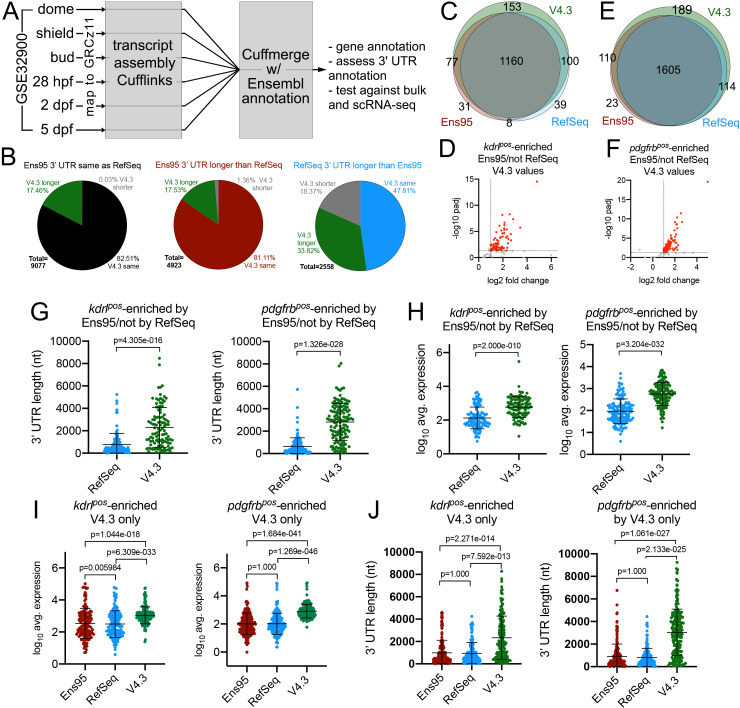
The V4.2 annotation improves detection of cell-type-specific genes from bulk RNA-seq data.(A) Schematic outline for generating a new zebrafish transcriptome annotation. See Results and Materials and methods sections for details. (B) Pie charts showing the proportion of reference genes with same, longer or shorter 3' UTR in the V4.3 annotation compared to relative 3' UTR length between Ens95 and RefSeq. (C, E) Venn diagrams showing intersection of reference genes with commonly annotated NCBI ID that are significantly enriched in (C) kdrlpos- or (E) pdgfrbpos-cells in each indicated annotation. (D, F) Volcano plots of reference genes with common NCBI ID identified as (D) kdrlpos- or (F) pdgfrbpos-enriched only by Ens95 in comparison to RefSeq. Indicated values are from the same genes quantified using V4.3. Red dots indicate log2 fold change >1 and adjp <0.05. (G) 3' UTR lengths and (H) log10 average expression (n = 3) using RefSeq and V4.3 for reference genes in the indicated dataset. (G, H) Data are not normally distributed, Wilcoxon matched-pairs signed-rank test, p values are indicated. Error bars denote mean and standard deviation. (I) Log10 average expression (n = 3) and (J) 3' UTR lengths across all annotations for reference genes uniquely identified as enriched in indicated transgene-positive cell type using V4.3 (log2 fold change >1, padj <0.05). Data are not normally distributed. Friedman test to assess variance (p<0.0001 in all cases). Dunn's multiple comparison test was used for pairwise comparisons, p values are indicated. Error bars denote mean and standard deviation.Figure 3—source data 1.List of SRA accession numbers, stages, and read numbers from GSE32900 for associated RNA-seq datasets used in this study.Figure 3—source data 2.List of manually-identified discrepancies in Ensembl gene annotation due to spurious fusionor overlapping transcripts.Table includes Ens95 gene symbol, gene ID, and spurious transcript ID. Persistence of observed discrepancy in Ens99 is indicated, as is previous status of curation in ZFIN. All of these have been reported to ZFIN.Figure 3—source data 3.RefSeq (worksheet 1) and Ens99 (worksheet 2) genes missing from the V4.2 annotation.Figure 3—source data 4.Novel genes from V4.2 genome annotation.This table includes information regarding blastx hits against zebrafish and human proteins, matches with lincRNAs, number of exons per gene, and whether the novel locus was included in the V4.3 annotation.Figure 3—source data 5.V4.3 gene information table, including unique LL ID numbers, associated Ens99 gene ID, NCBI ID, and ZFIN gene ID numbers, gene symbols, and gene names.Annotation notes are also included regarding the relative strength of coordinate-based incorporation of NCBI (Entrez) and Ens99 gene identifiers.Figure 3—source data 6.Output from DESeq2 analysis comparing kdrlpos and kdrlneg RNA-seq.Gene expression levels were quantified using RSEM with the V4.3 annotation. Median ratio normalized expression values are shown for each sample, along with adjusted p-value and log2 fold change. Matching Ensembl and NCBI gene IDs are included.Figure 3—source data 7.Output from DESeq2 analysis comparing pdgfrbpos and pdgfrbneg RNA-seq.Gene expression levels were quantified using RSEM with the V4.3 annotation. Median ratio normalized expression values are shown for each replicate, along with adjusted p-value and log2 fold change. Matching Ensembl and NCBI gene IDs are included.Figure 3—source data 8.Worksheet 1 - Output from DESeq2 analysis comparing Nr2f2pos and Nr2f2neg RNA-seq.Gene expression levels were quantified using RSEM with the V4.3 annotation. Median ratio normalized expression values are shown for each replicate, along with adjusted p-value and log2 fold change. Matching Ensembl and NCBI gene IDs are included. Worksheet 2 – Nr2f2pos-enriched genes with matched entries from reference gene set (Figure 2—source data 2) and associated 3' UTR lengths (Figure 2—source data 2).